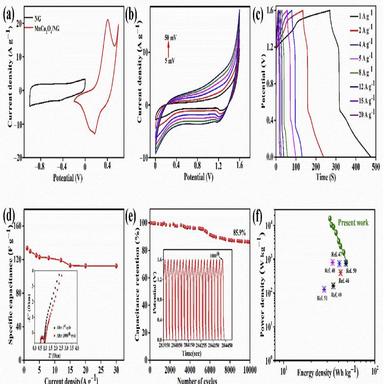
(a) CV curves of the NG and the MnCo2O4/NG 2D/2D hybrid nanoarchitectures electrodes at 10 mV s1 in a three electrode cell, (b) CV curves of the MnCo2O4/NG 2D/2D//NG asymmetric supercapacitor at different sweep rates (550 mV s1 ), (c) galvanostatic chargeedischarge curves of the MnCo2O4/NG 2D/2D//NG asymmetric supercapacitor at different current densities, (d) specific capacitance vs. current density of MnCo2O4/NG 2D/2D//NG asymmetric supercapacitor, (e) cyclic stability of the MnCo2O4/NG 2D/2D//NG asymmetr